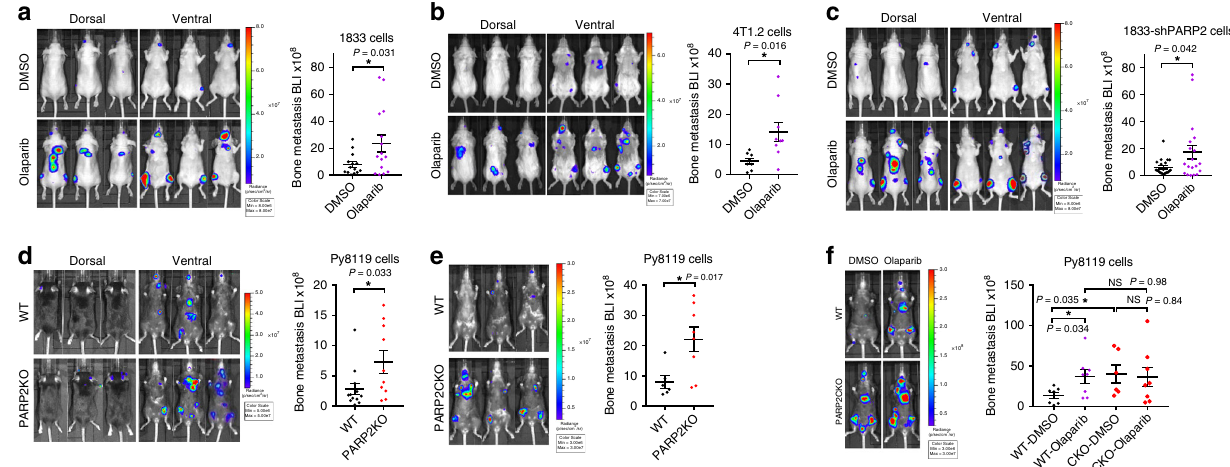
Fig. 1 PARP2 de fi ciency increases breast cancer bone metastasis. Olaparib treatment increased bone metastasis of MDA231-BoM-1833 cells in nude mice ( n = 14, a ) and 4T1.2 cells in BALB/c mice ( n = 9, b ). c Bone metastases of PARP2KD 1833 cells after olaparib treatment ( n = 20) were more than DMSO control ( n = 15). d Bone metastasis of Py8119 cells was increased in PARP2KO mice ( n = 10) compared with B6 wild-type (WT) control mice ( n = 13). e PARP2CKO mice ( n = 8) developed more bone metastases of Py8119 cells than B6 WT mice ( n = 6). f Treatment of olaparib increased bone metastasis of Py8119 cells in B6 WT mice ( n = 8), but not in PARP2CKO mice ( n = 8), compared with DMSO-treated WT ( n = 7) or